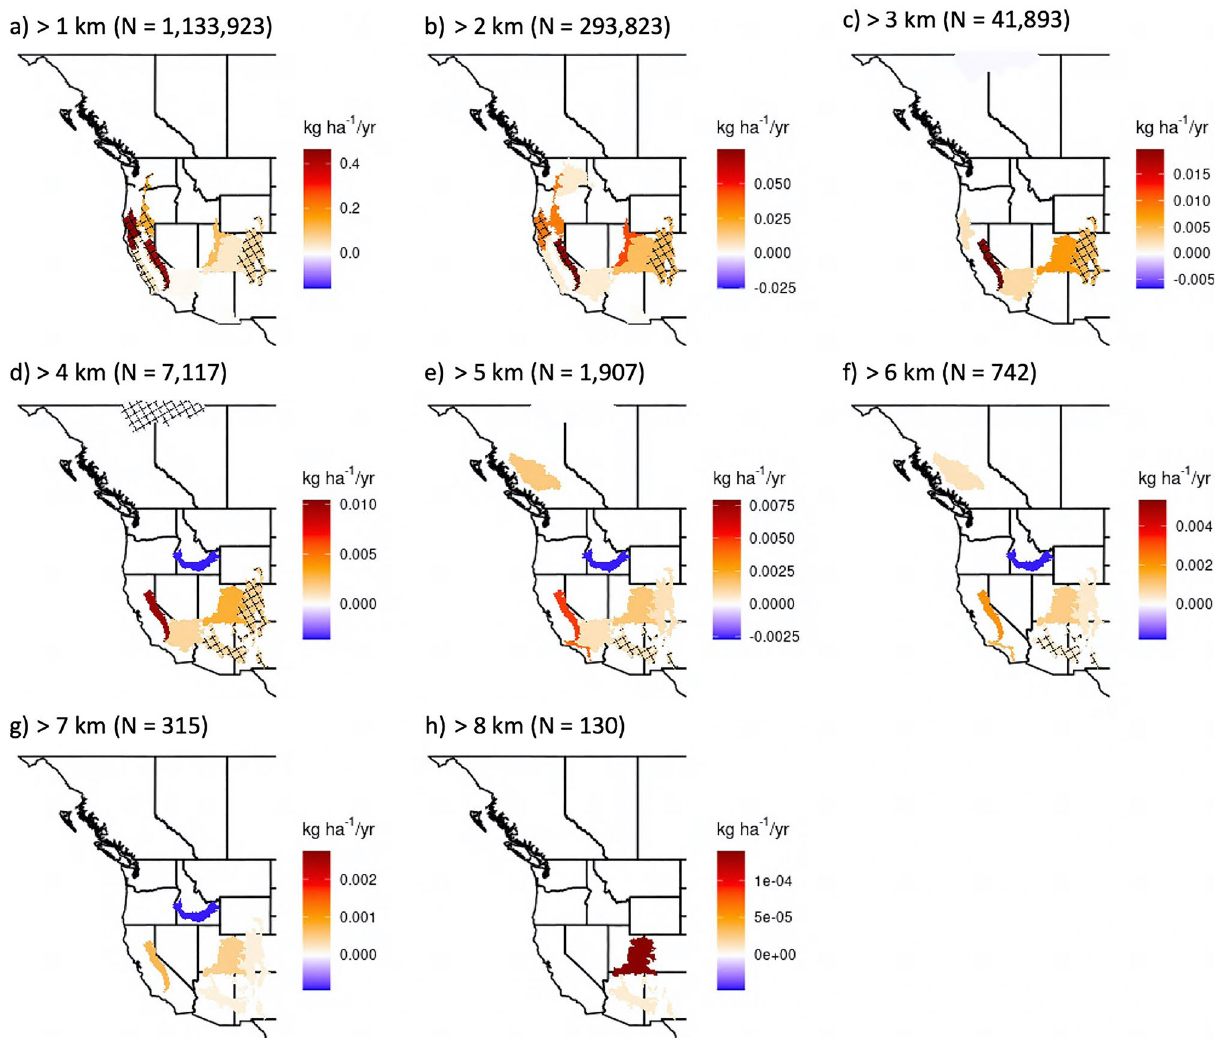
Figure 4. Trends in the PM 2.5 mass injected above ( a ) 1 km, ( b ) 2 km, ( c ) 3 km, ( d ) 4 km, ( e ) 5 km, ( f ) 6 km, ( g ) 7 km, and ( h ) 8 km, by wildfires during the months of August and September of the years 2003–2020. N-values indicate the number of plumes out of the original ~ 4.6 million that remain above the threshold altitude. Only trends significant at p < 0.1 are displayed, with a crosshatch overlaid on trends with p < 0.05. Note the differences in the ranges represented by the color